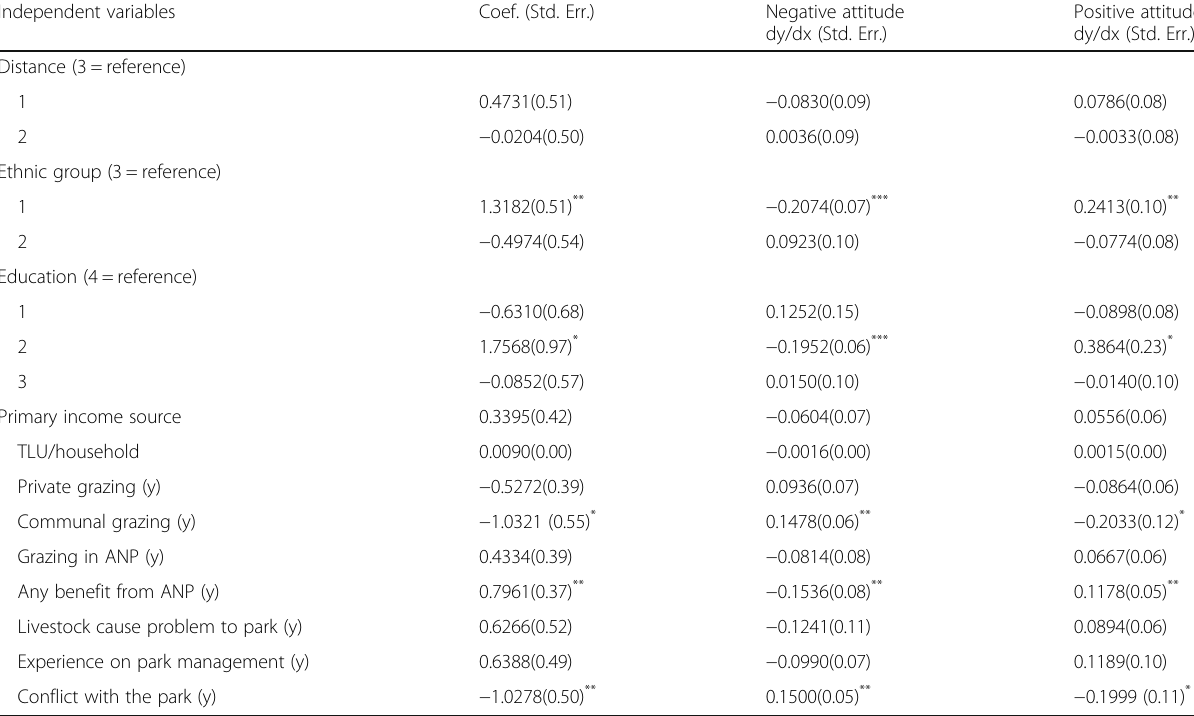
Table 4 Variables included in the optimum ordinal regression model for Afar, Ittu, and Kereyu ethnic groups around Awash National Park (ANP), Ethiopia ( n = 180) Independent